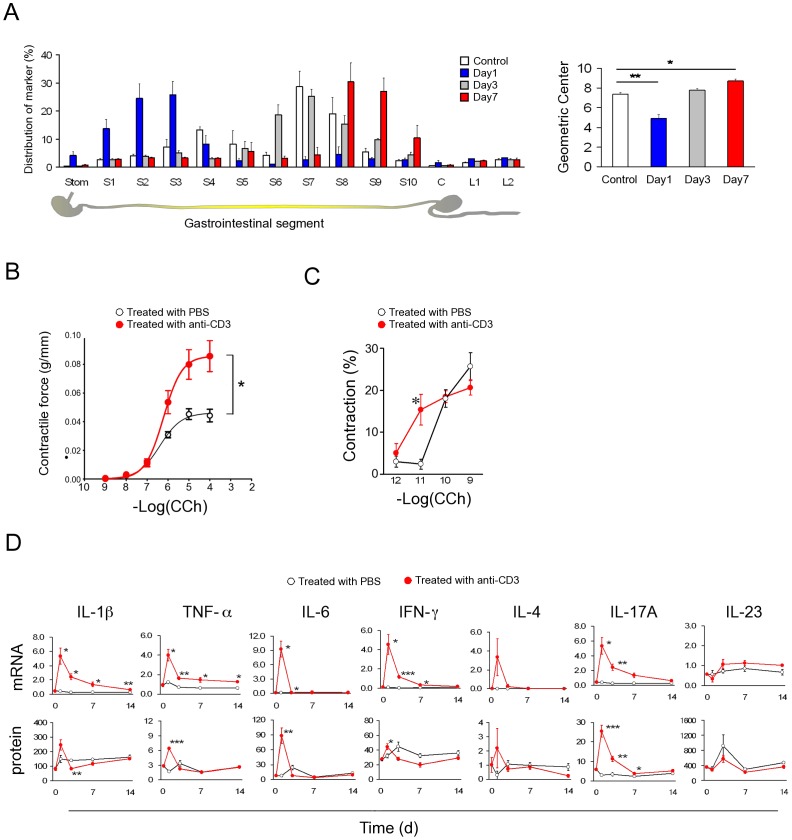
T cell activation induces GI hypermotility after resolution of inflammation, with sustained upregulation of IL-17A protein.(A) GI transit distribution histograms and calculated geometric center (GC) values from the histograms. GC has been frequently and reliably used to estimate GI transit. Stom, stomach; S1–S10, small intestine segments 1–10; C, caecum; L1–2, Large intestine segments 1–2. Control (PBS-treated), day 1, 3 and 7 after αCD3 injection (n = 3 for each group of mice). (B) Carbachol (CCh)-stimulated dose-response curves of contractile response of SI strips prepared from day 7 with or without αCD3 treatment (n = 7). CCh was added cumulatively. (C) CCh-stimulated dose-response curves of contractile response of SI longitudinal SMCs prepared from day 7 with or without αCD3 treatment. The respective concentration of CCh was added separately (n = 4). (D) Time-dependent changes of mRNA and protein levels of various Th-cytokines in the intestinal tissue measured by quantitative RT-PCR and Bio-plex assay, respectively (n = 4∼8). Numerical data represent means ± s.e.m. *P<0.05, **P<0.01 versus control/PBS-treated, repeated measure ANOVA (B), Student's t-test (A, C, D) with Bonferroni correction for multiple comparison (A).